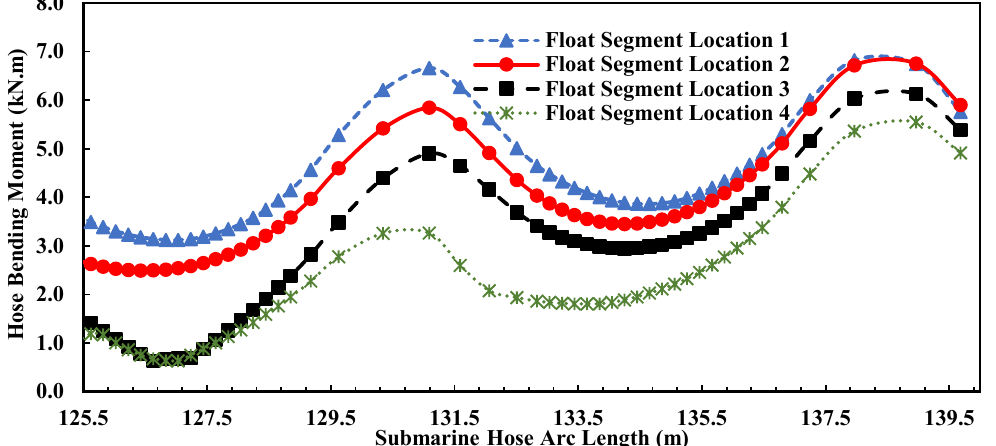
Figure 32. Effect of float buoyancy length location along hose arc length .